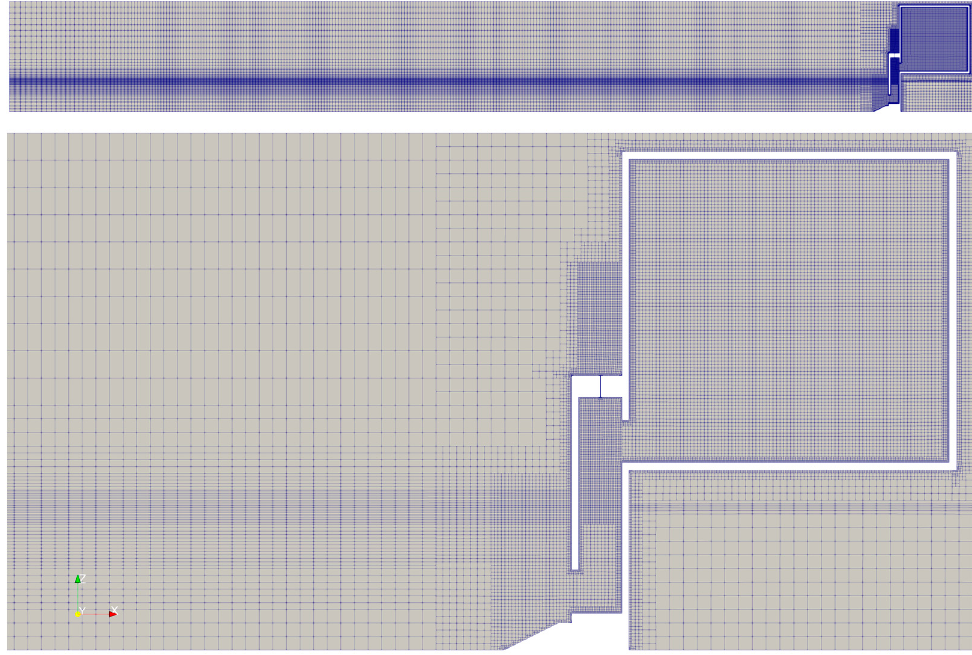
Figure 4. General view of the computational mesh ( top ) and detail of the testing-zone region ( bottom ) for a wave condition with T = 1.2 s and H = 0.04 m (in model dimensions).